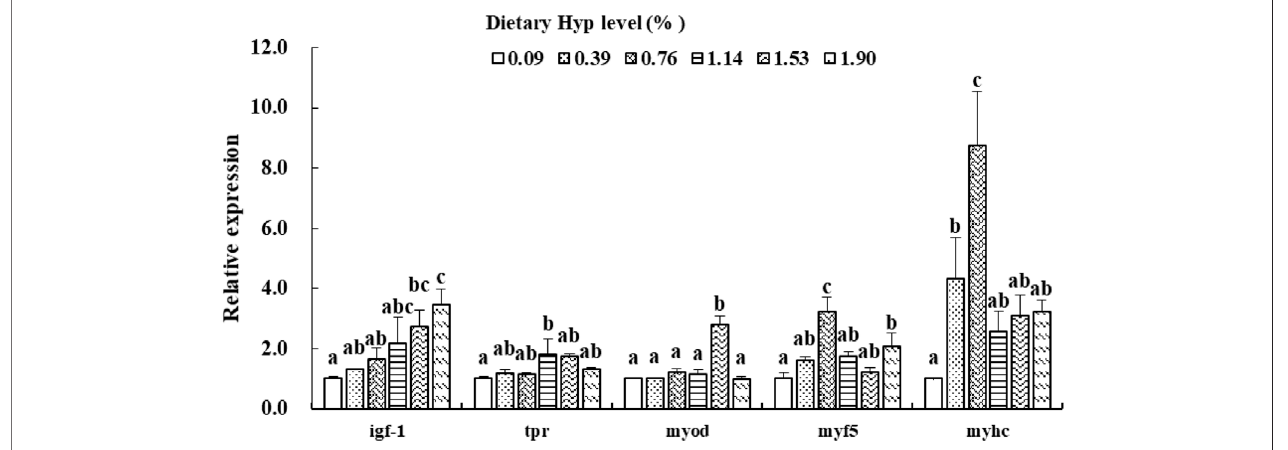
FIGURE 5 | Relative expressions of igf-1 , tor , myod , myf5 and myhc in muscle of ITCC fed with different experimental diets for 8 weeks. Data are present as Means ± SE (n = 6). Different lowercase letters above the same group of bars represent signi fi cant difference between the corresponding groups ( p < 0.05).